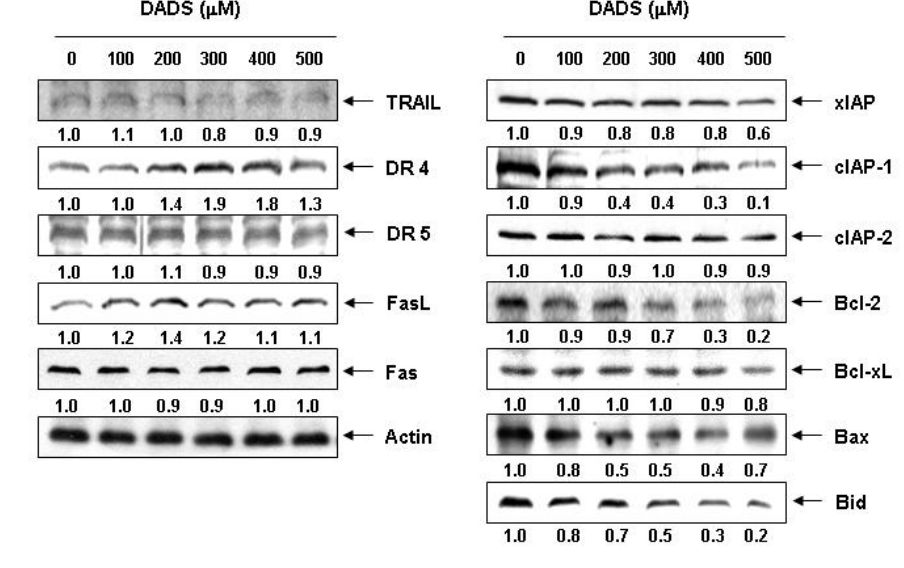
Figure 3. Effect of DADS on the levels of death receptor-related, Bcl-2 and IAP family proteins in DU145 cells. Cells were incubated with the indicated concentrations of DADS for 48 h. The cells were lysed, and the cellular proteins were then separated by SDS-polyacrylamide gels and transferred onto nitrocellulose membranes. The membranes were probed with the indicated antibodies. The proteins were visualized using an ECL detection system. Actin was used as an internal control. The numbers represent the average densitometric analyses as compared with actin in, at a minimum, two or three different